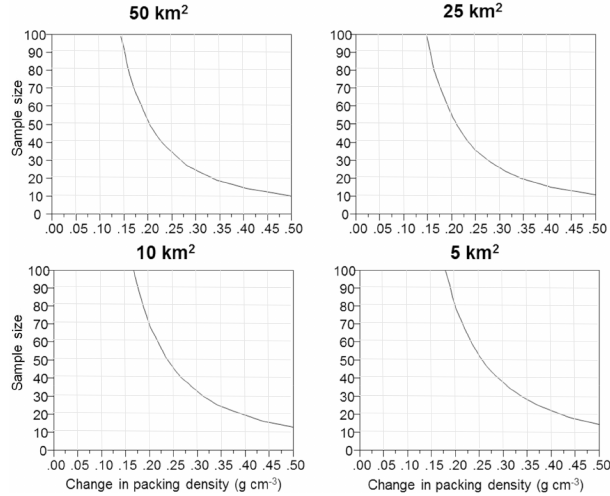
Figure 3. Power analysis using a model-based approach in which the variability was estimated given a particular block size using the variogram described in Methods S9. Soil water retention character-